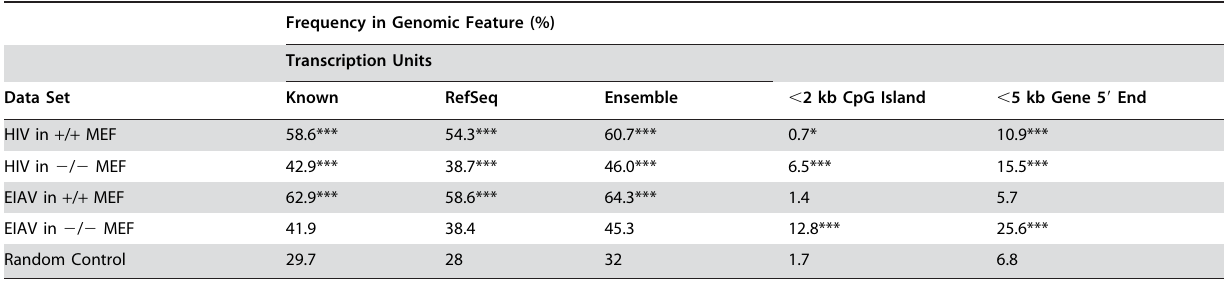
Table 3. Integration frequency in the presence and absence of LEDGF/p75 near mapped genomic features in the murine genome. .. ... .... ... ... .... ... ... .... ... ... .... ... ... .... ... ... .... ... ... .... ... ... .... ... ... .... ... ... .... ... ... .... ... ... .... ... ... .... ... ... .... ... ... . Frequency in Genomic Feature (%) Transcription